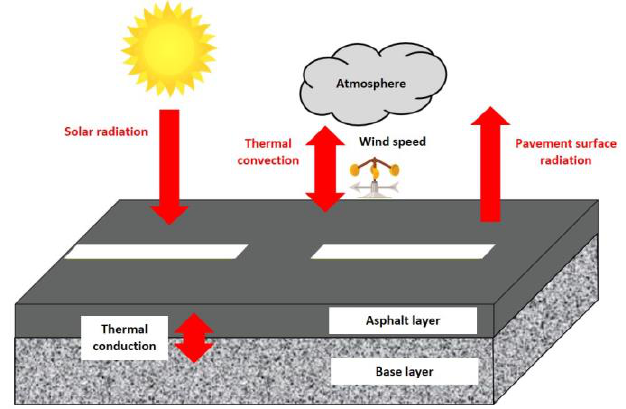
Figure 1. Schematic diagram of heat transfer modes for asphalt pavement.